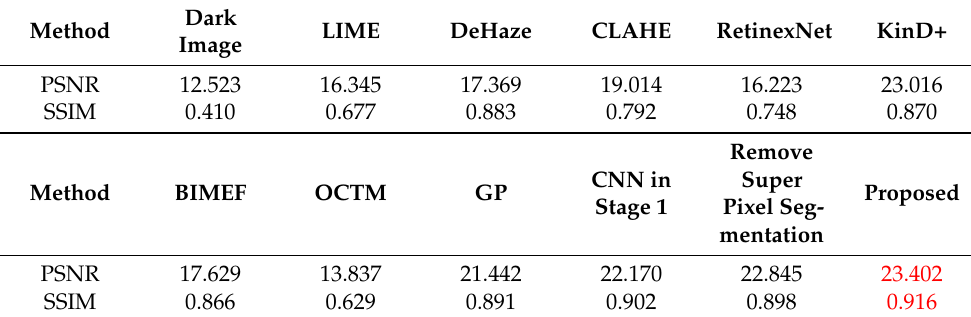
Table 1. Average PSNR and SSIM. The best data is marked in red.